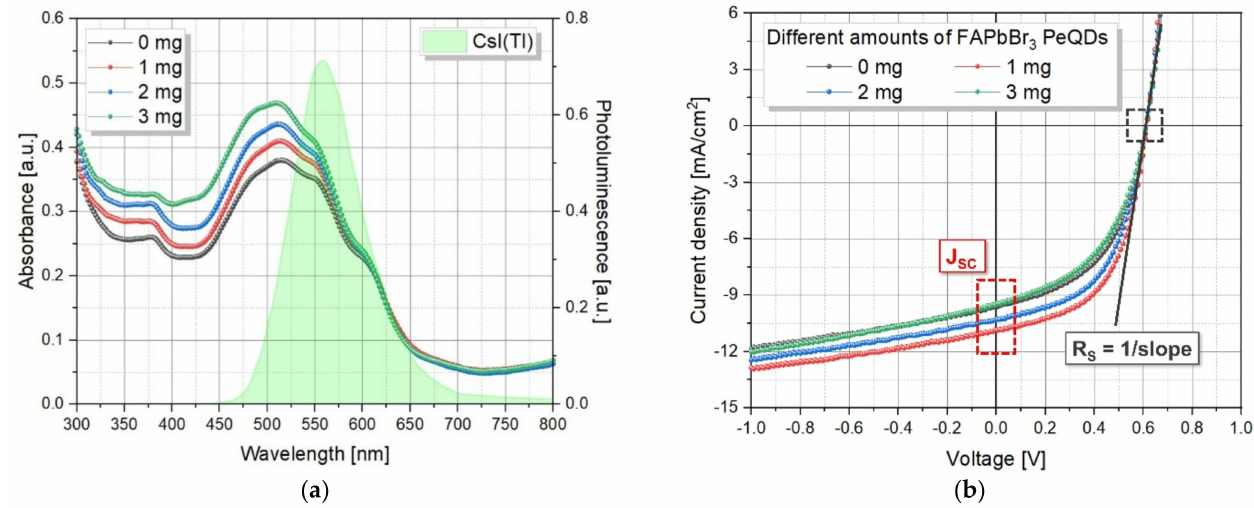
Figure 4. ( a ) The absorption spectra of P3HT:PC 71 BM:FAPbBr 3 PeQDs (0, 1, 2, and 3) mg films and the emission spectrum of the CsI(TI) scintillator, ( b ) J − V curves of the detectors based on the P3HT:PC 71 BM active layer with different amounts of FAPbBr 3 PeQDs.